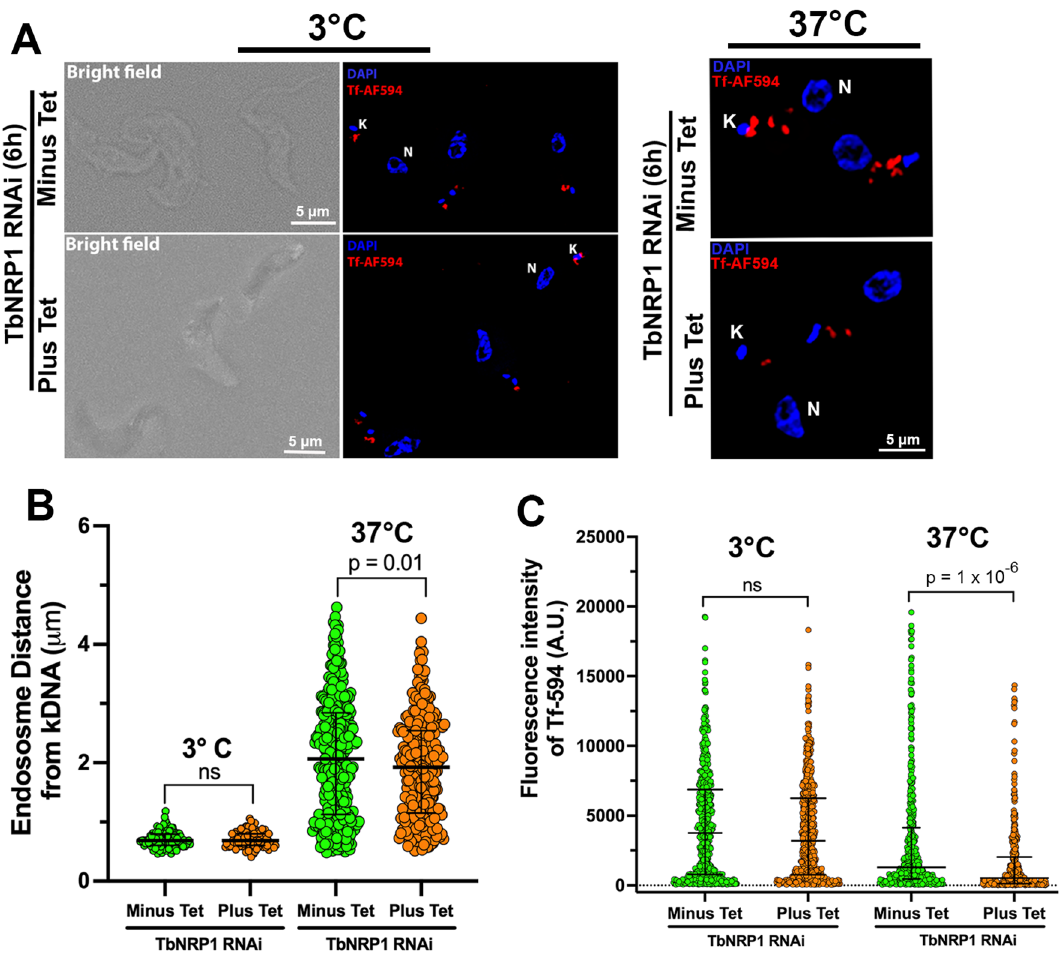
Figure 3. Binding (at 3 °C), and Uptake (at 37 °C) of Tf after knockdown of TbNRP1. (A) Left panel : TbNRP1 knockdown does not affect binding of Tf at flagellar pocket. Knockdown of NRP1 was induced for 6 h with 1 µg/mL tetracycline. Trypanosomes were incubated with Tf-Alexa594 (25 µg/ml) at 3 °C for 15 min. Cells were fixed with PFA, washed and mounted with Vectashield containing DAPI. Representative images of cells showing Tf-AF594 at the flagellar pocket region in uninduced (Minus Tet) and induced (Plus Tet) TbNRP1 RNAi cells. Right panel: Internalization of Transferrin is reduced after knockdown of TbNRP1. Knockdown of NRP1 was induced for 6 h with 1 µg/mL tetracycline. Trypanosomes were incubated with Tf-Alexa594 (25 µg/ml) at 37 °C for 2 min. Cells were fixed with PFA, washed and mounted with Vectashield containing DAPI. Images of cells showing internalized Tf-AF594 in uninduced (Minus Tet) and induced (Plus Tet) TbNRP1 RNAi cells. K, Kinetoplast; N, Nucleus. ( B ) Quantitation of motility of bound or internalized Tf. Scatter dot plot presents distance between kDNA, near flagellar pocket (site of endocytosis) and Tf at 3 °C or 37 °C in uninduced (Minus Tet) and induced (Plus Tet) cells. ( C ) Endosomes contain less Tf after knockdown of NRP1. Scatter dot plot represents Tf-AF594 fluorescence intensity (arbitrary units) in uninduced (Minus Tet) and induced (Plus Tet) cells at 3 °C or 37 °C. Bars denote median with interquartile range. p value was calculated using Kolmogorov– Smirnov